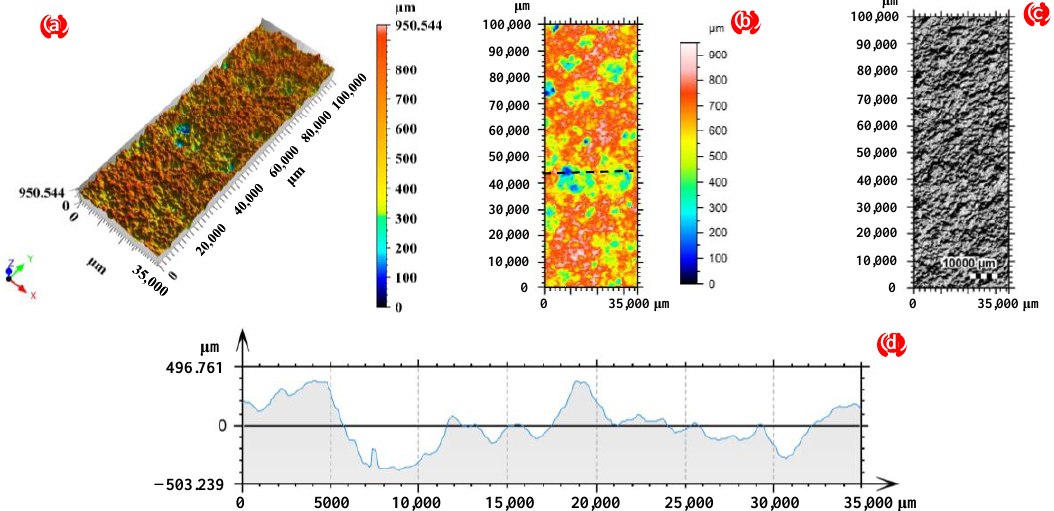
Figure 3. Three-dimensional morphology scanning results of the front side of C6-1: ( a ) 3D view of the surface, ( b ) pseudo color view of the surface, ( c ) photo copy, and ( d ) profile curve.